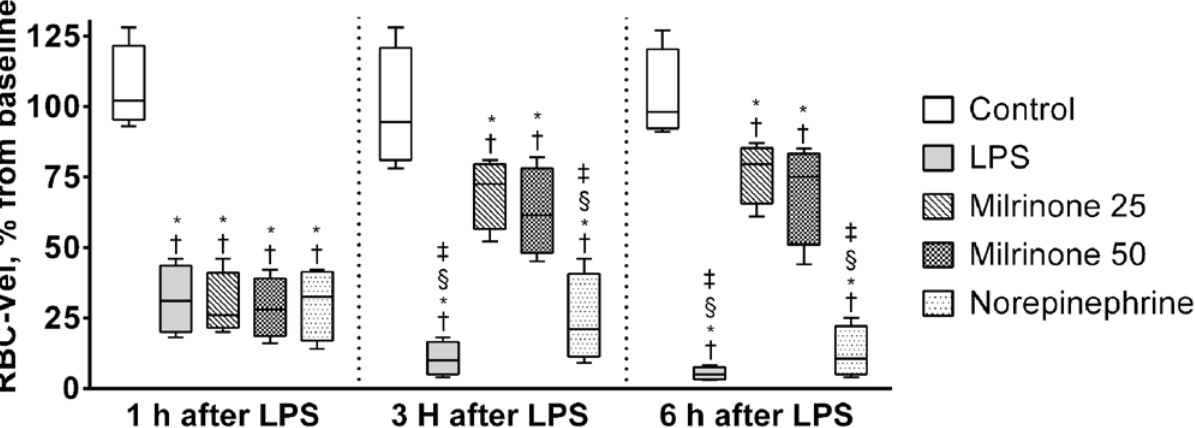
Fig 5. Evolution of red blood cell velocity in capillaries (RBC-Vel) during the experimental period. Values of RBC-Vel are presented as ratios relative to baseline values. Sequential measurements were performed after one, three, and six hours of LPS injection. Control, non-endotoxemic animals (n = 10); LPS, endotoxemic animals (n = 10); Milrinone 25, endotoxemic and milrinone 0.25 μ g.kg -1 .min -1 treated animals (n = 10); Milrinone 50, endotoxemic and milrinone 0.50 μ g.kg -1 .min -1 treated animals (n = 10); Norepinephrine, endotoxemic and norepinephrine treated animals (n = 10). † p < 0.05 vs . group baseline; * p < 0.05 vs . Control group at the same time point; ‡ p < 0.05 vs . Milrinone 25 group at the same time point; § p < 0.05 vs . Milrinone 50 group at the same time